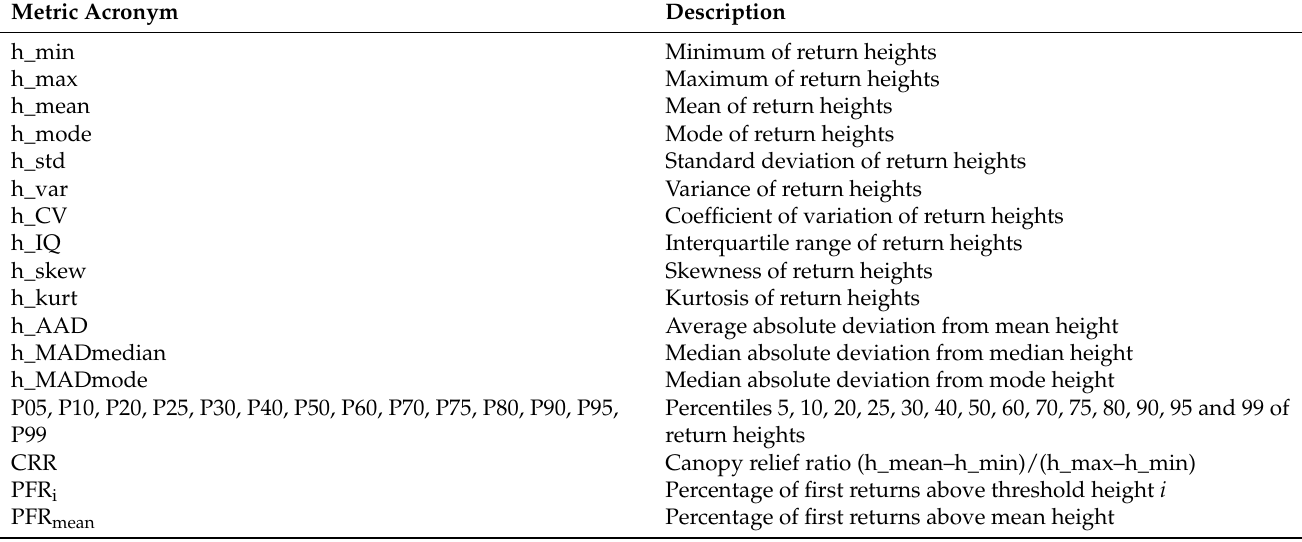
Table 2. ALS metrics extracted in the field plots and tested as potential predictor variables in the canopy fuel